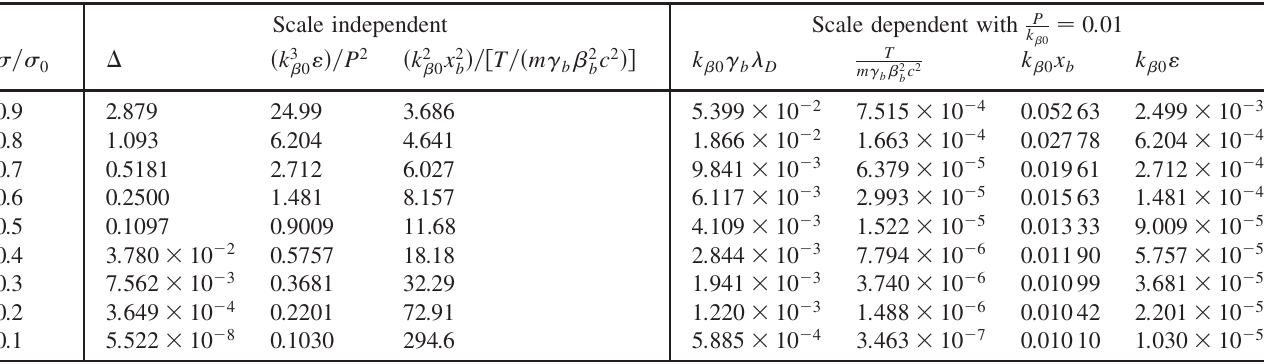
TABLE II. Dimensionless parameters for a sheet-beam thermal equilibrium presented in Fig. 4 calculated for specified values of (cid:7)=(cid:7) . Scale independent parameters applicable to any physical size thermal equilibrium and scale dependent parameters employed for 0 the specific choice equilibrium employed in Fig. 4 are grouped in separate columns to the left and right. Scale independent